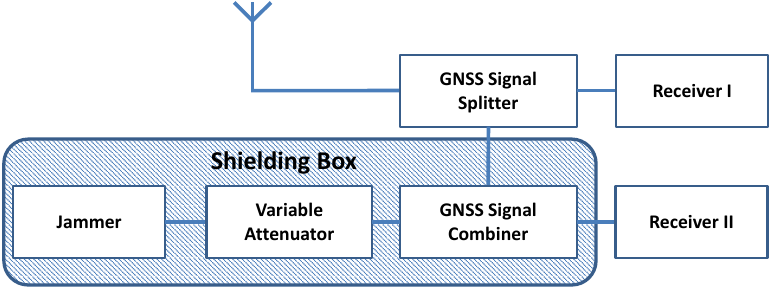
Figure 5. A schematic overview of the setup used in laboratory